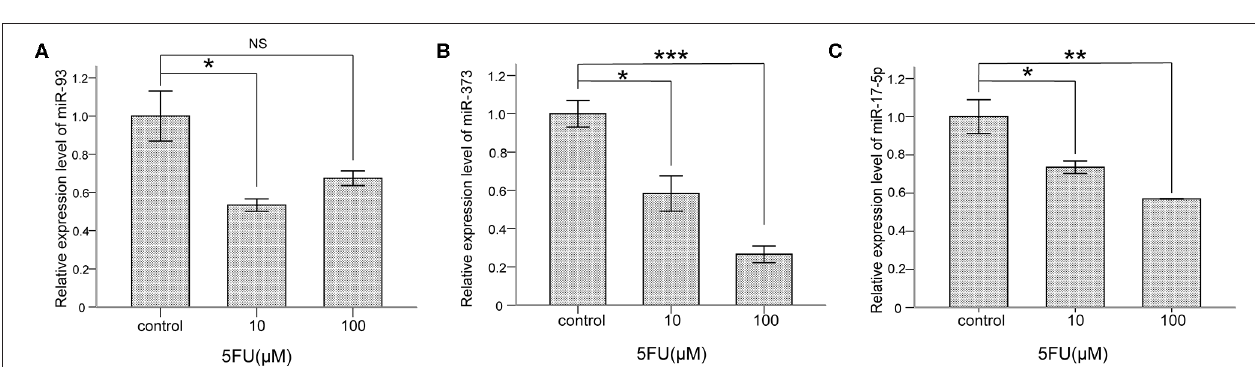
FIGURE 4 | 5-FU repressed the levels of miR-93, miR-373, and miR-17-5p in NCI-H460 cells. (A) The mRNA level of miR-93 was lower in 10 µ M 5-FU-treated cells than control group cells (* P < 0.05, Bonferroni’s multiple comparisons test) but not in 100 µ M. (B) The mRNA level of miR-373 was lower in 5-FU-treated cells than control group cells (10 µ M, * P < 0.05, 100 µ M, *** P < 0.001, Bonferroni’s multiple comparisons test). (C) The mRNA level of miR-17-5p was lower in 5-FU-treated cells than control group cells (10 µ M, * P < 0.05, 100 µ M, ** P < 0.01, Bonferroni’s multiple comparisons test).